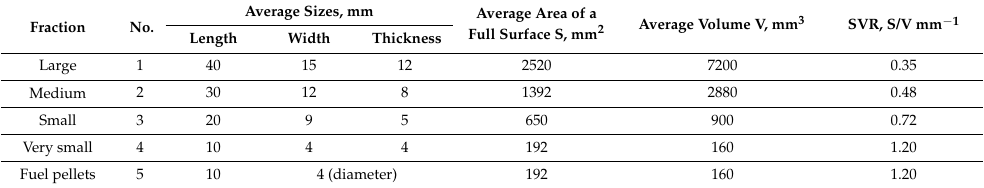
Table 2. Fuel fraction characteristics.